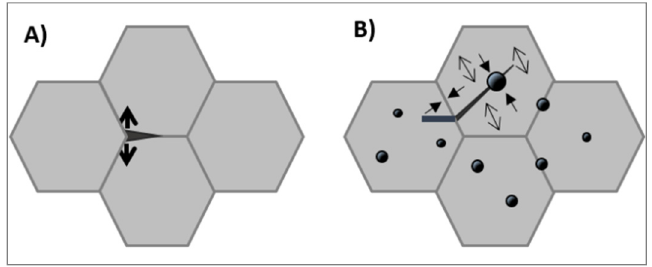
Figure 9. Schematic illustration of the residual stress field in ( a ) pure Al 2 O 3 , due to thermal expansion anisotropy during cooling and ( b ) Al 2 O 3 /SiC nanocomposites, due to thermal expansion coefficient mismatch between matrix and second-phase. In both figures, the preferential crack path is